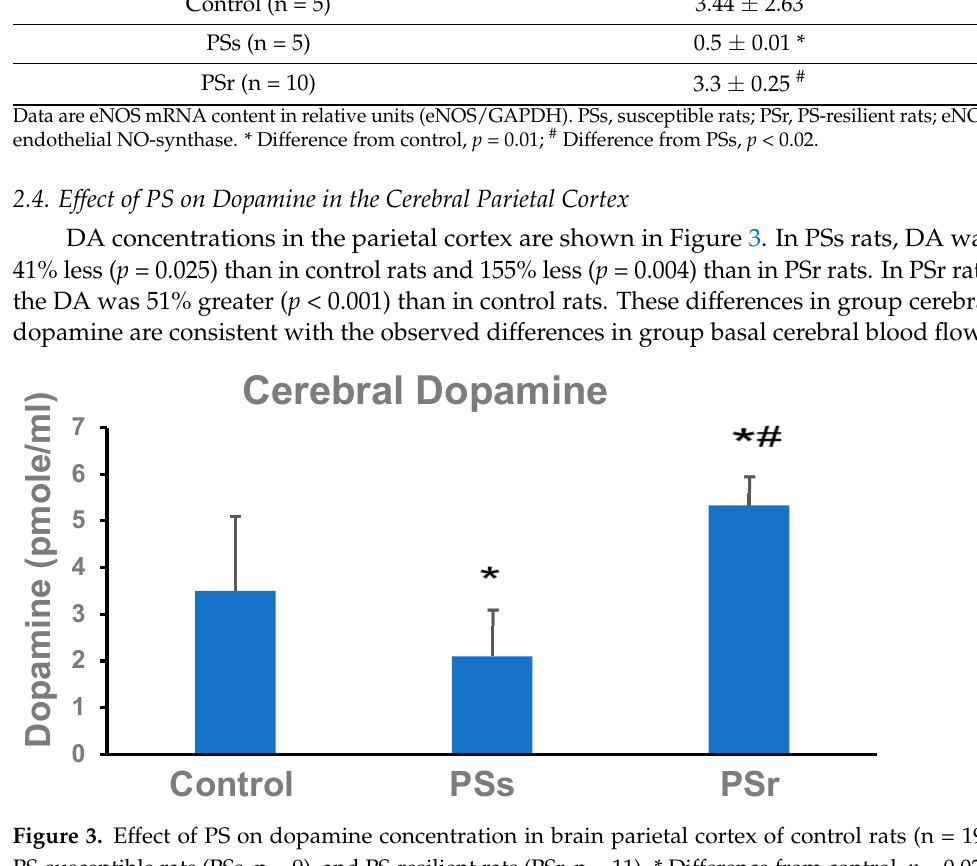
Figure 4. Effect of PS on plasma corticosterone concentration in plasma of control rats (n = 20), PS- susceptible rats (PSs, n = 9), and PS-resilient rats (PSr, n = 11). * Difference from control, p < 0.001. # Difference from PSs, p < 0.001). 2.6. Effect of PS on Hemostatic Parameters Regarding the PS-impaired blood coagulation parameters (Table 3), for PSs rats, APTT and PT were 25% and 26% less than in control rats, respectively ( p < 0.001 for both). The fibrinogen concentration and platelet aggregation were increased by 24% and 28%, respectively ( p < 0.001 for both).